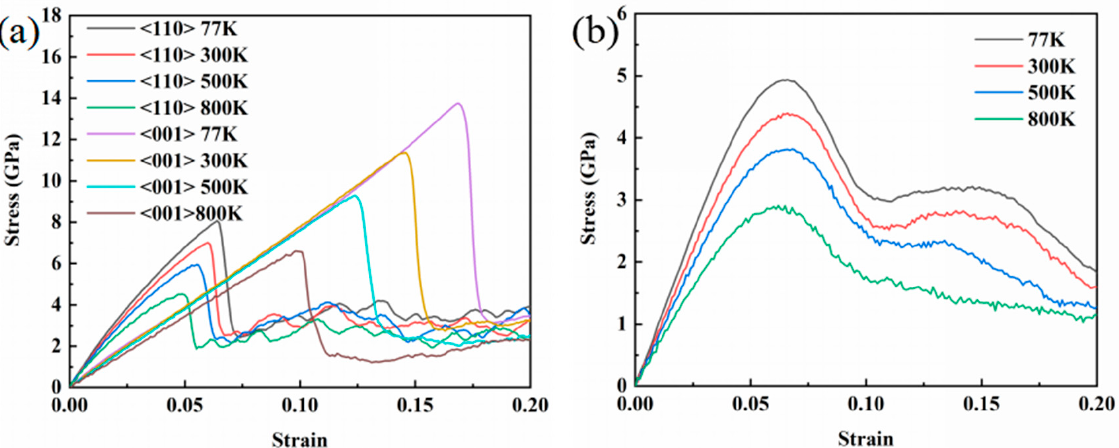
Figure 2. ( a ) Tensile stress-strain curves in <001> and <110> directions at different temperatures, ( b ) compressive stress-strain curves in <001> direction at different temperatures. Table 1. Tensile and compressive strength of CoCrNi at different temperatures. Temperatures